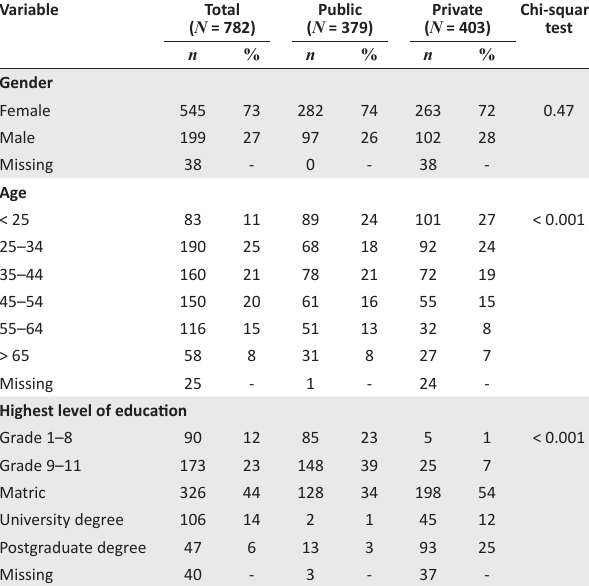
TABLE 2: Knowledge questions, correct answers by practice type ( p -values from chi-square tests). Variable